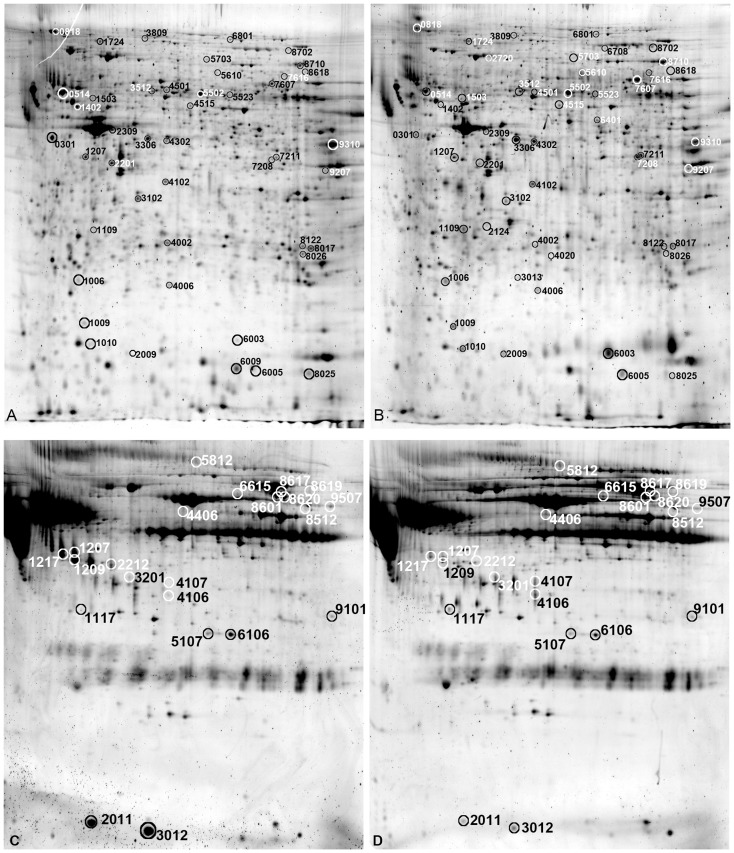
2-DE proteome graphs of the mid small intestine and blood plasma.
Panel

A
: small intestine, untreated; Panel B, small intestine, AB; Panel C, plasma, untreated; Panel D, plasma, AB. Spot number was assigned by the analysis software and correlated with the ones presented in
Tables 1
 and
2
.